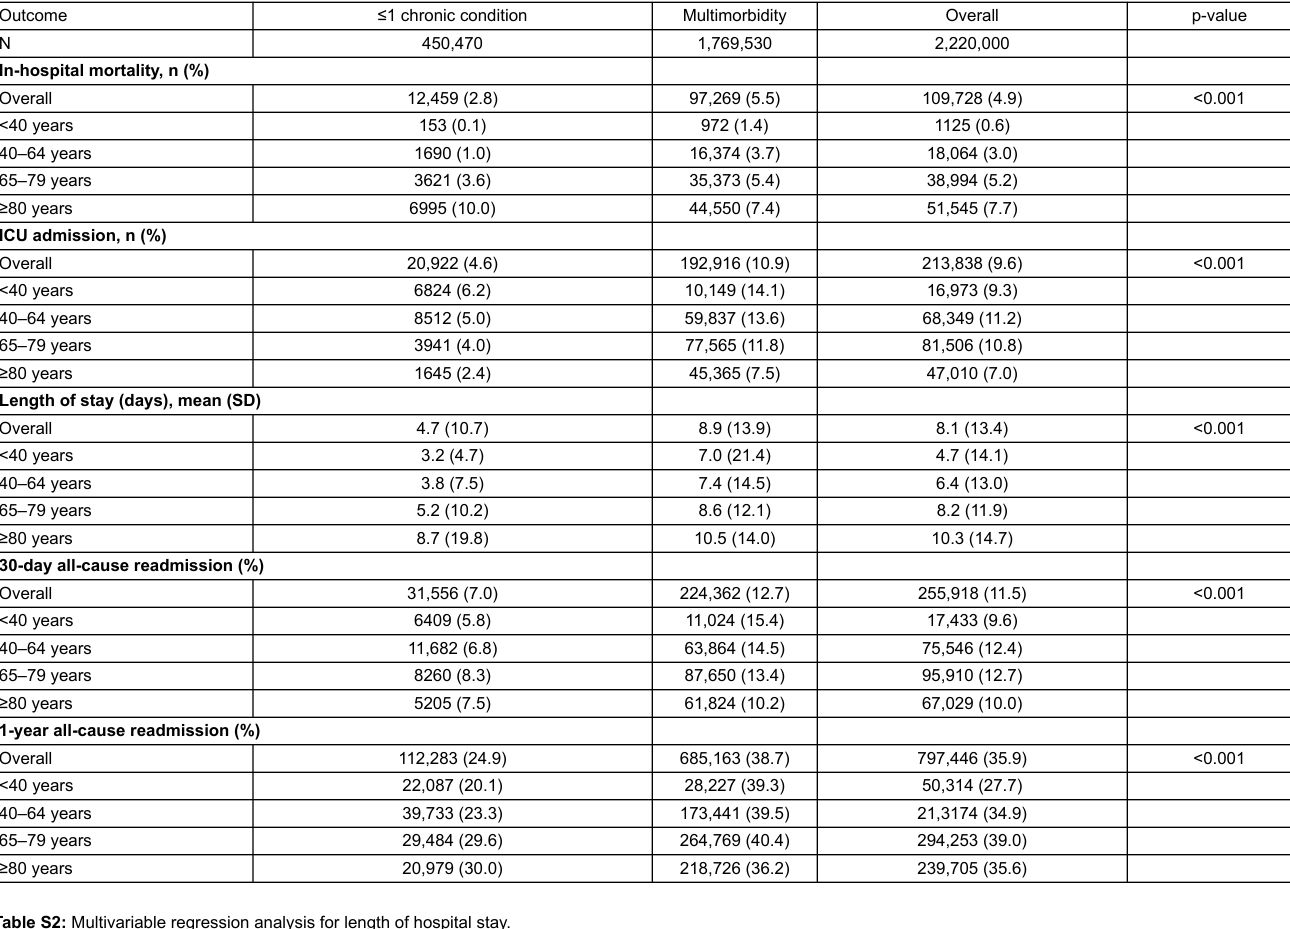
Table S1: Unadjusted estimates for in-hospital mortality, intensive care unit (ICU) admission, length of hospital stay and readmission rates.